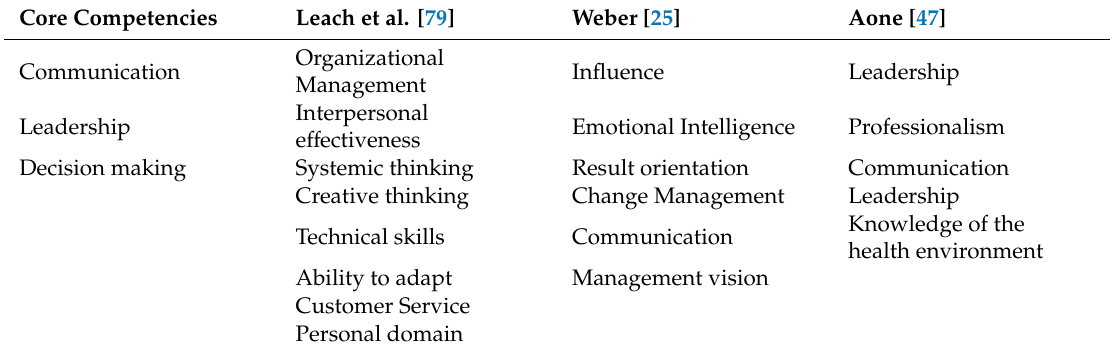
Table 6. Comparison of core